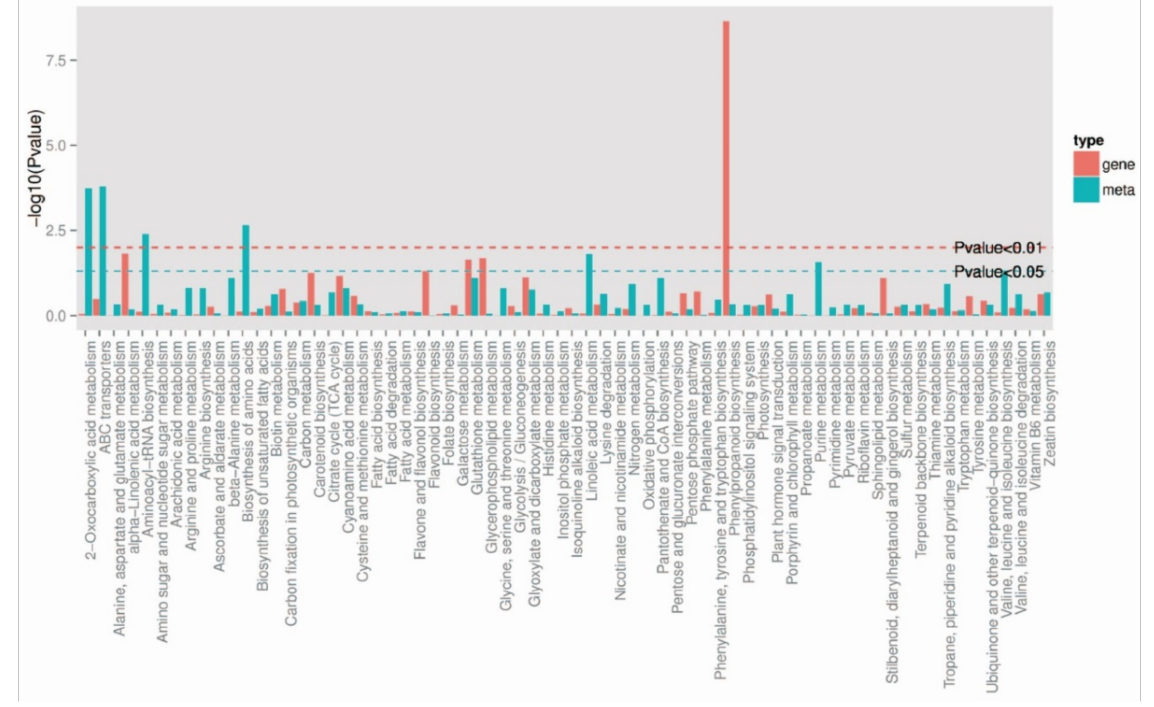
Figure 9. DEMs and DEGs co-enrichment map in F and S cell lines of Korean